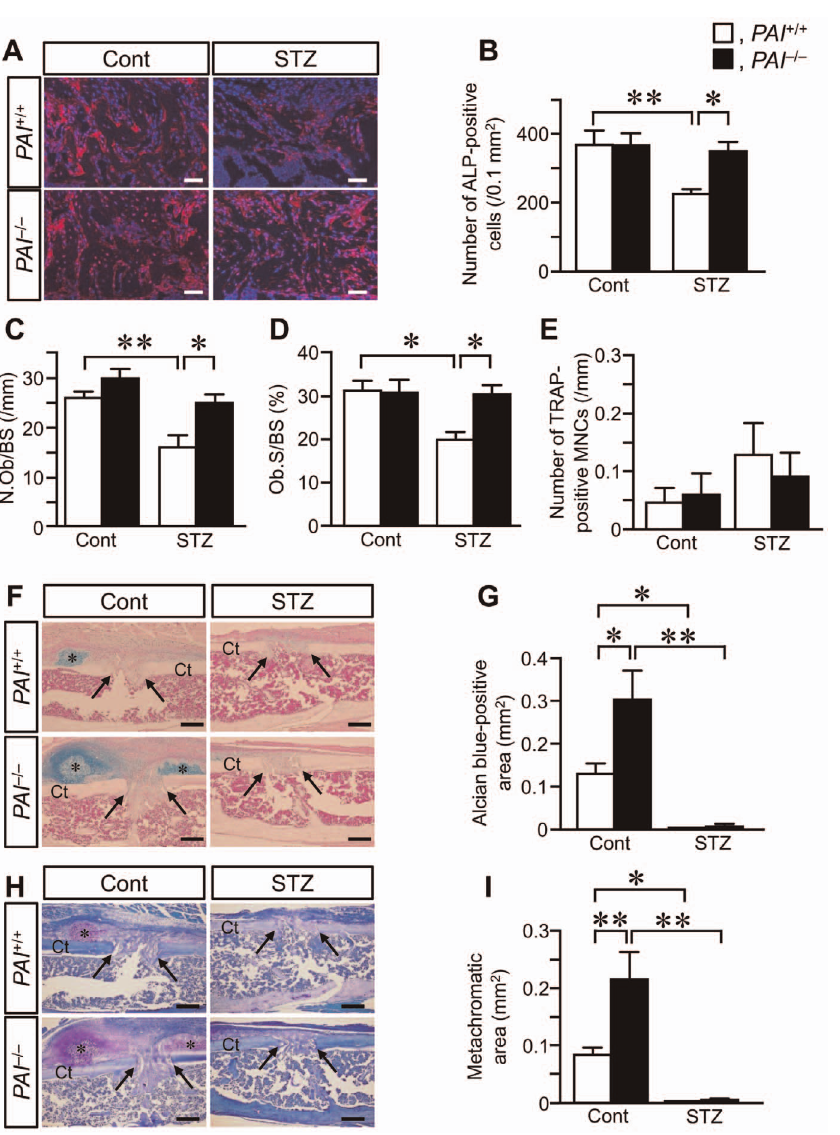
Figure 3. Histological analysis of the damaged site after a femoral bone defect. (A) Microphotographs of ALP-positive cells at the damaged site on day 7 after a femoral bone defect in female PAI-1 + / + and PAI-1 2 / 2 mice with or without STZ treatment. (B) The number of ALP-positive cells per 0.1 mm 2 of the microscopic field in the damaged site on day 7 after a femoral bone defect in female PAI-1 + / + and PAI-1 2 / 2 mice with or without STZ treatment. (C) The number of ALP-positive osteoblast-like cells per 1 mm of bone surface (N.Ob/BS) at the damaged site on day 7 in female PAI-1 + / + and PAI-1 2 / 2 mice with or without STZ treatment. (D) Osteoblast surface per bone surface (Ob.S/BS) at the damaged site on day 7 in female PAI-1 + / + and PAI-1 2 / 2 mice with or without STZ treatment. (E) The number of TRAP-positive multinucleated cells (MNCs) per 1 mm of bone surface at the damaged site on day 7 in female PAI-1 + / + and PAI-1 2 / 2 mice with or without STZ treatment. (F) Microphotographs of Alcian blue-stained sections at the damaged site on day 7 after a femoral bone defect in female PAI-1 + / + and PAI-1 2 / 2 mice with or without STZ treatment. The sections were counterstained with nuclear fast red. Asterisks indicate the Alcian blue-positive region. (G) Quantification of the Alcian blue-positive area at the damaged site on day 7 in female PAI-1 + / + and PAI-1 2 / 2 mice with or without STZ treatment. (H) Microphotographs of toluidine blue-stained sections at the damaged site on day 7 after a femoral bone defect in female PAI-1 + / + and PAI-1 2 / 2 mice with or without STZ treatment. Asterisks indicate the metachromatic region. (I) Quantification of the area of the metachromatic region in the sections stained with toluidine blue at the damaged site on day 7 in female PAI-1 + / + and PAI-1 2 / 2 mice with or without STZ treatment. The results are from experiments performed on 5-6 mice in each group (A, F, H). Scale bars indicate 50 (A) and 300 m m (F, H). The arrows indicate the edge of the damaged site in the inner cortex (F, H). Data represent the mean 6 SEM of 5-6 mice (B-E, G, I). * p , 0.05, ** p , 0.01. Cont, control. Ct, cortical bone .